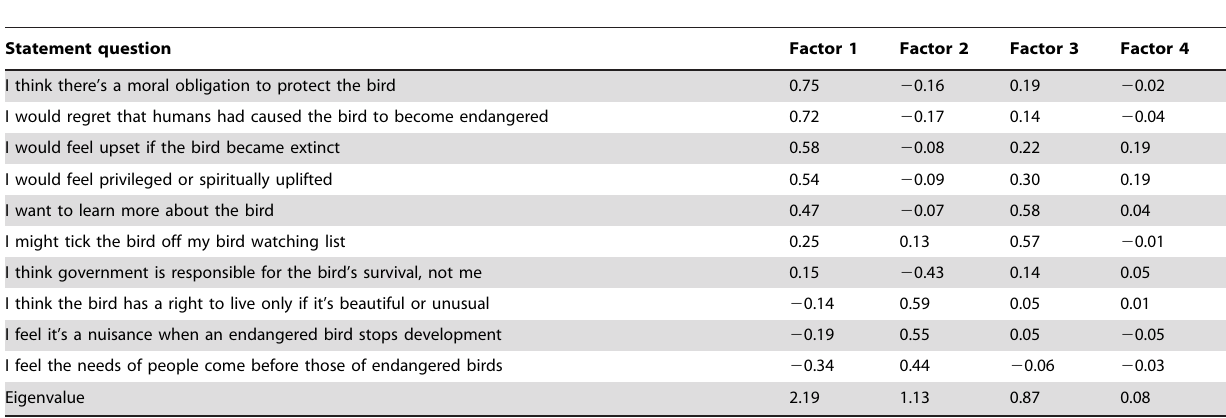
Table 4. Results of factor analysis extracting four common factors explaining the correlations amongst responses to Likert-type statement